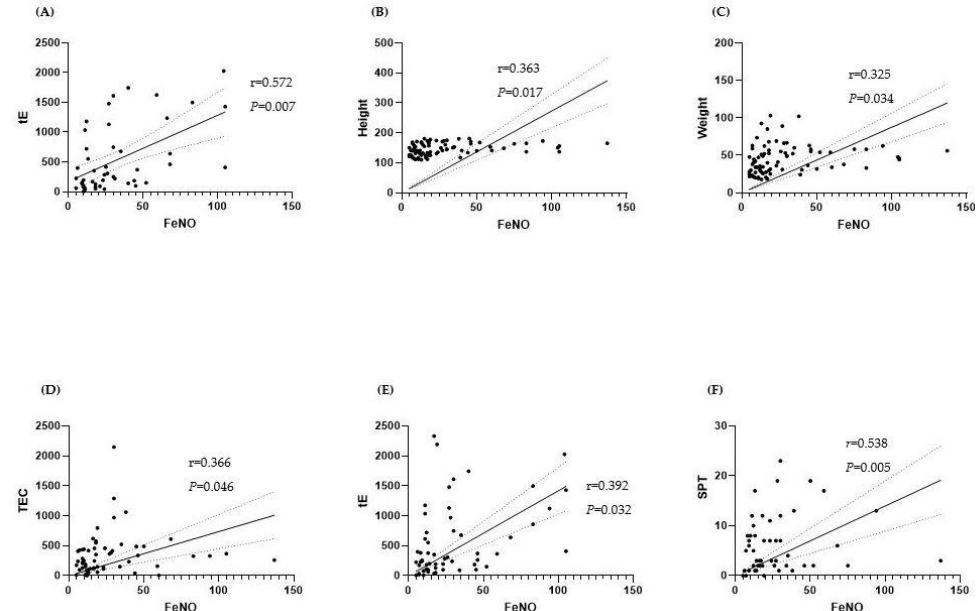
Figure 1. Correlations between FeNO and other factors in each group. ( A ) Correlations between FeNO and total immunoglobulin E in the asthma group. ( B ) Correlations between FeNO and height in the rhinitis group. ( C ) Correlations between FeNO and weight in the rhinitis group. ( D ) Correlation between FeNO and blood eosinophil count in the rhinitis group. ( E ) Correlation between FeNO and total immunoglobulin E in the rhinitis group. ( F ) Correlation between FeNO and the numbers of positive skin prick test in the rhinitis group. FeNO, fractional exhaled nitric oxide; BA, bronchial asthma; AR, allergic rhinitis; tE, total immunoglobulin E; TEC, total eosinophil count; SPT, skin prick test.